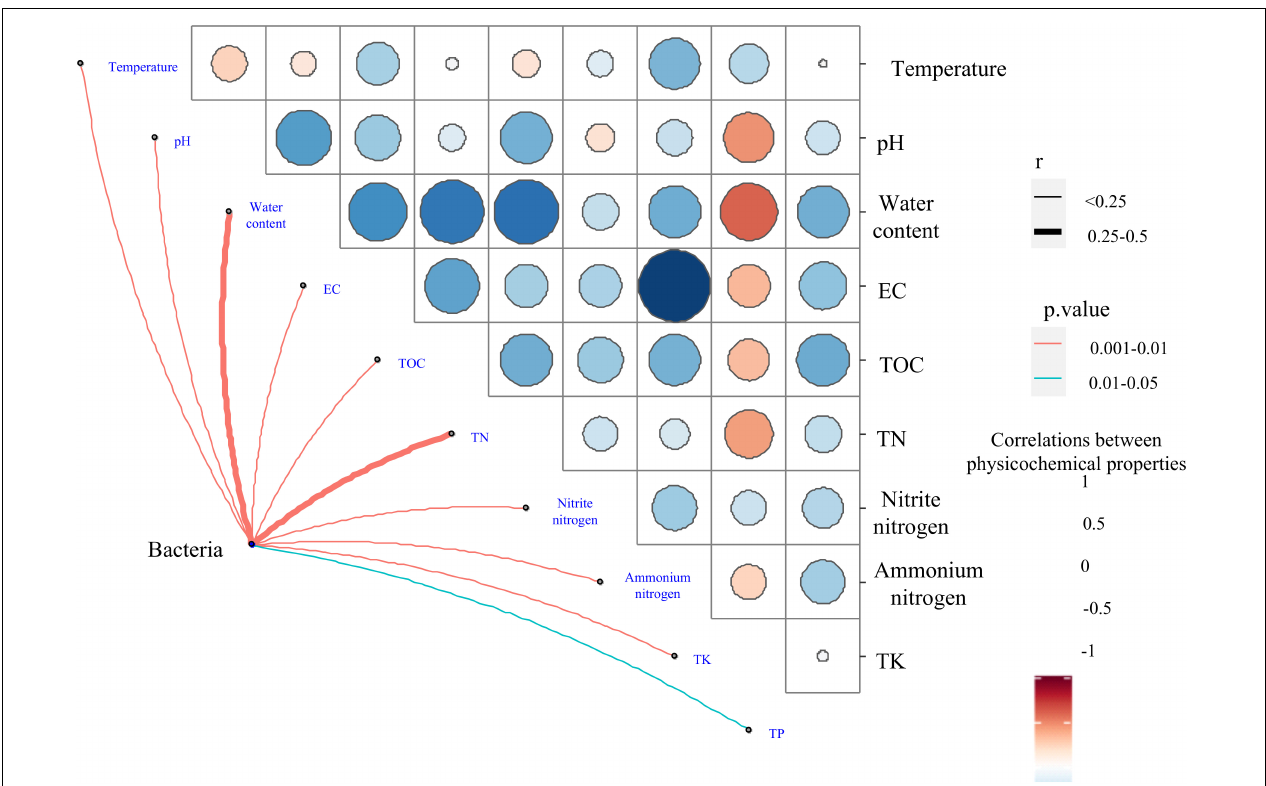
FIGURE 7 | Relationships between bacterial community compositions at the genus level and physicochemical variables revealed by the Mantel test. Line width corresponds to the partial Mantel’s r statistic, and line color denotes the statistical significance based on 999